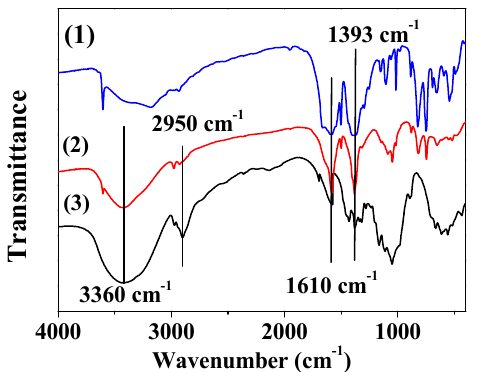
Figure 5. Fourier transform-infrared (FT-IR) spectra of (1) MOF-5, (2) MOF-5–CMC, and (3) CMC.